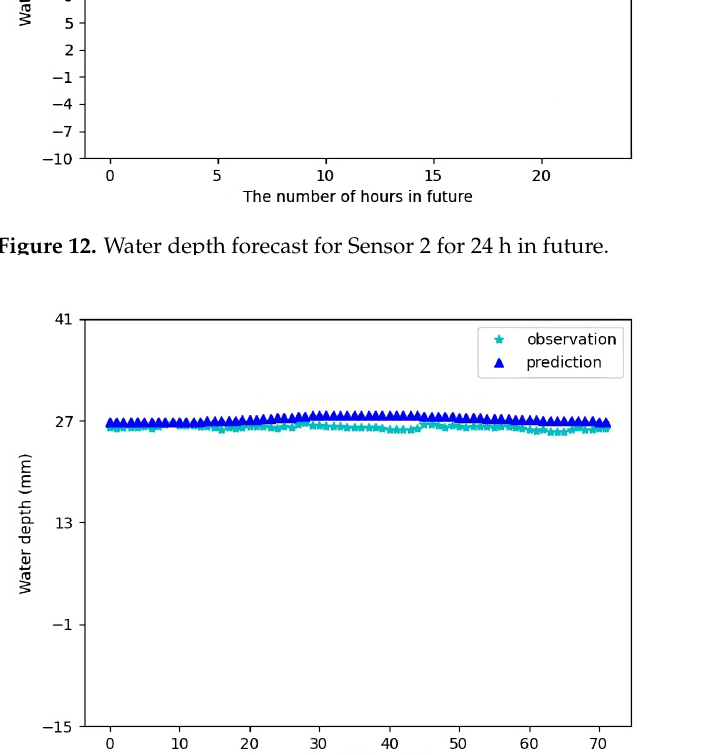
Figure 13. Water depth forecast for Sensor 2 for 72 h in